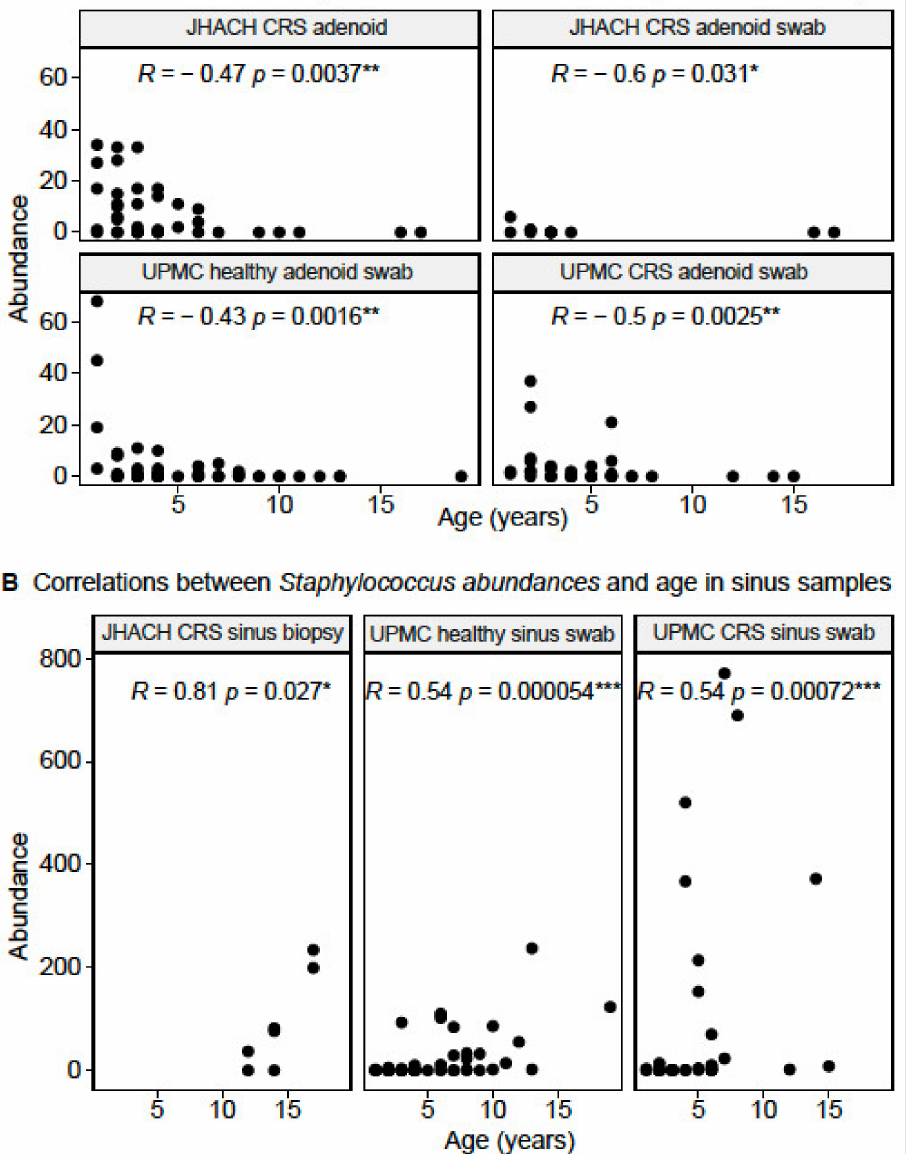
Figure 4. Spearman correlations between age and ( A ) Streptobacillus ; and ( B ) Staphylococcus abun- dances in subgroups of adenoid- and sinus-derived samples, respectively, from chronic rhinosinusitis (CRS) and healthy participants in the Johns Hopkins All Children’s Hospital (JHACH) and/or Uni- versity of Pittsburgh Medical Center (UPMC) cohorts. All correlations were statistically significant, where * denotes a p -value of ≤ 0.05; ** denotes a p -value of ≤ 0.01; and *** denotes a p -value of ≤